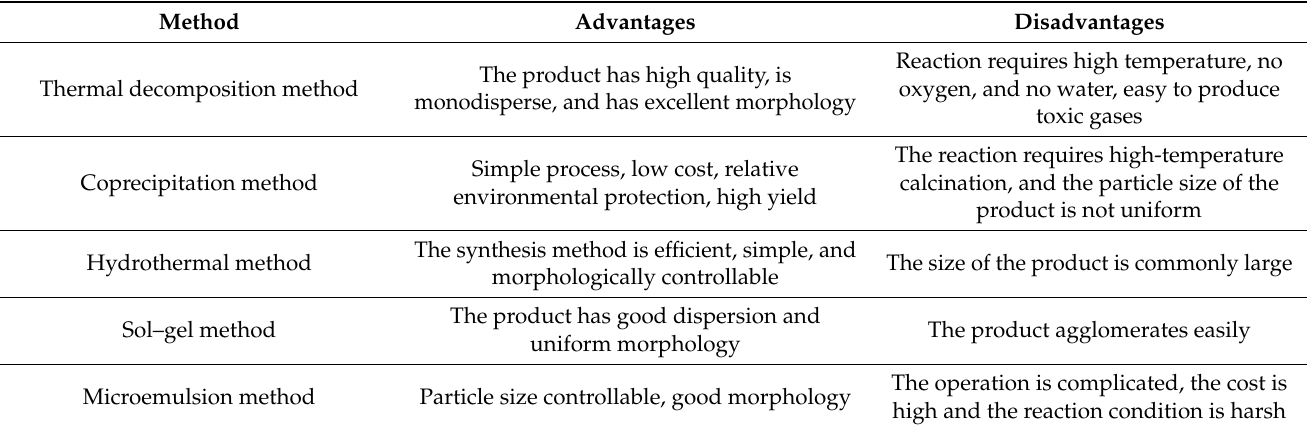
Table 4. Advantages and disadvantages of UCNPs preparation methods. Adapted with permission from Qin YK et al. [115].